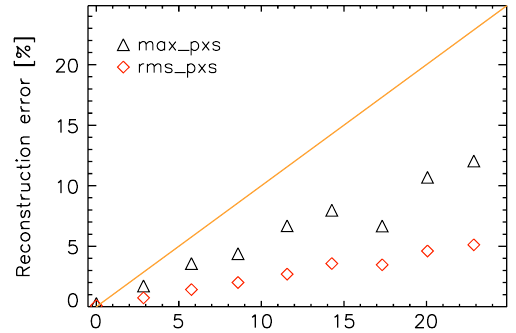
FIG. 8. Error of the tomographic reconstruction of the phan- tom 8 for the 32 pixel configuration as a function of the noise level added to the line integrated signals: maximum error (black) and rms error (red) as defined in Eq. (14). The line is the reference line x ¼ y .